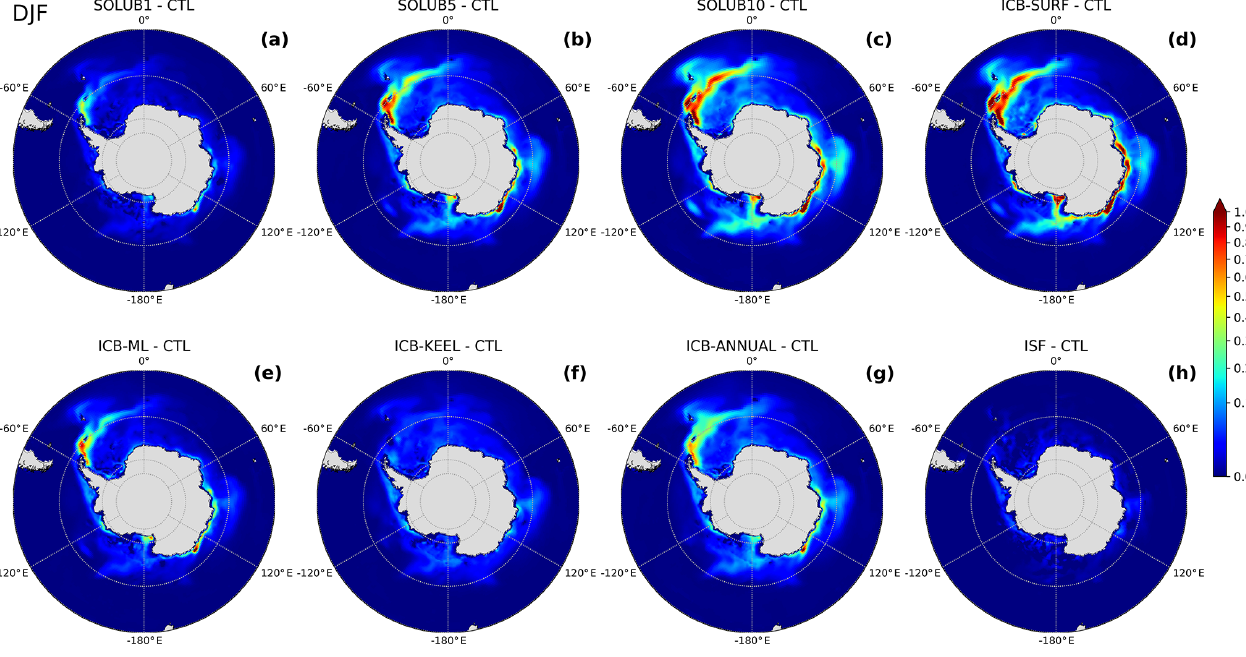
Figure 9. Difference in surface chlorophyll concentrations in summer (December, January, and February) between the (a) SOLUB1, (b) SOLUB5, (c) SOLUB10, (d) ICB-SURF, (e) ICB-ML, (f) ICB-KEEL, (g) ICB-ANNUAL, and (h) ISF experiments and the CTL experi- ment (experiments minus CTL) in the Southern Ocean, south of 45 ◦